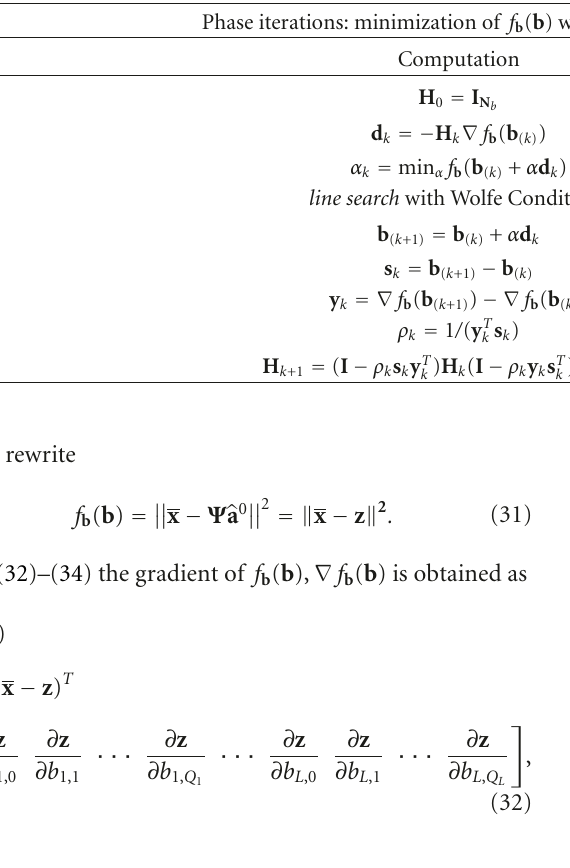
Table 3: Minimization of f b ( b ) with quasi-Newton (BFGS)